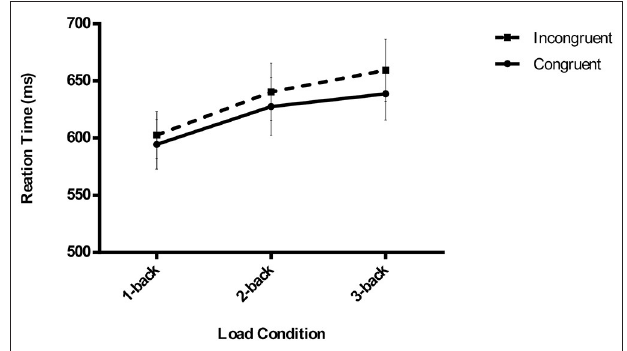
FIGURE 2 | Mean reaction times of unconscious visuomotor priming are depicted as a function of executive attention load (1-back vs. 2-back vs. 3-back) and congruency conditions (congruent vs. incongruent) in Experiment 1. The error bars denote